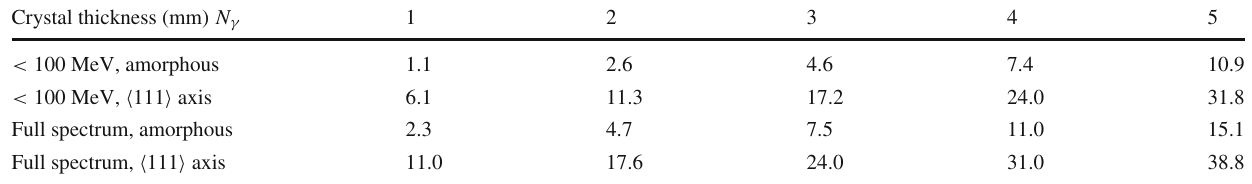
Table 1 Simulated number of photons produced by one incident 6 GeV electron for two tungsten (W) crystal orientations: crystal aligned along (cid:2) 111 (cid:3) axes and random orientation of the crystal. Low energy cutoff used in simulations is 5 MeV